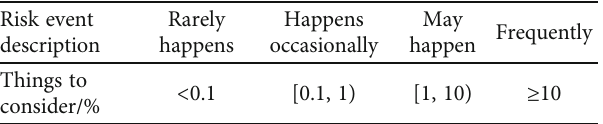
Table 3: Index of the probability level of risk